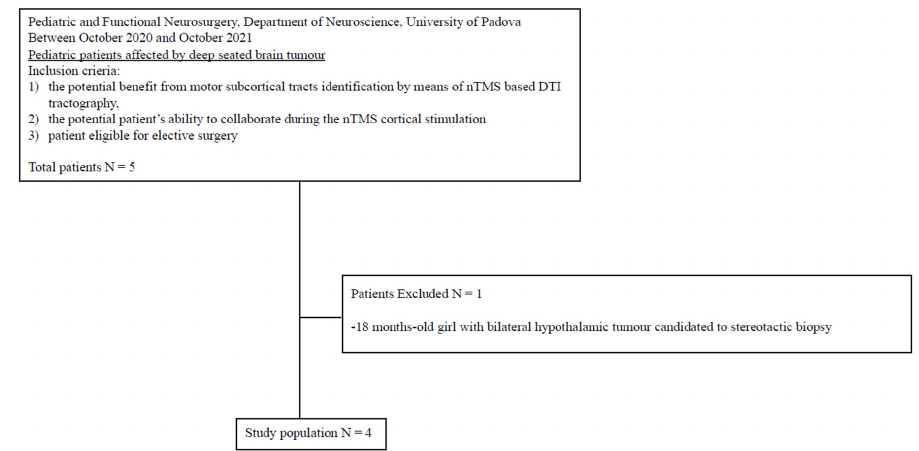
Figure 1. Flow diagram of patient selection.